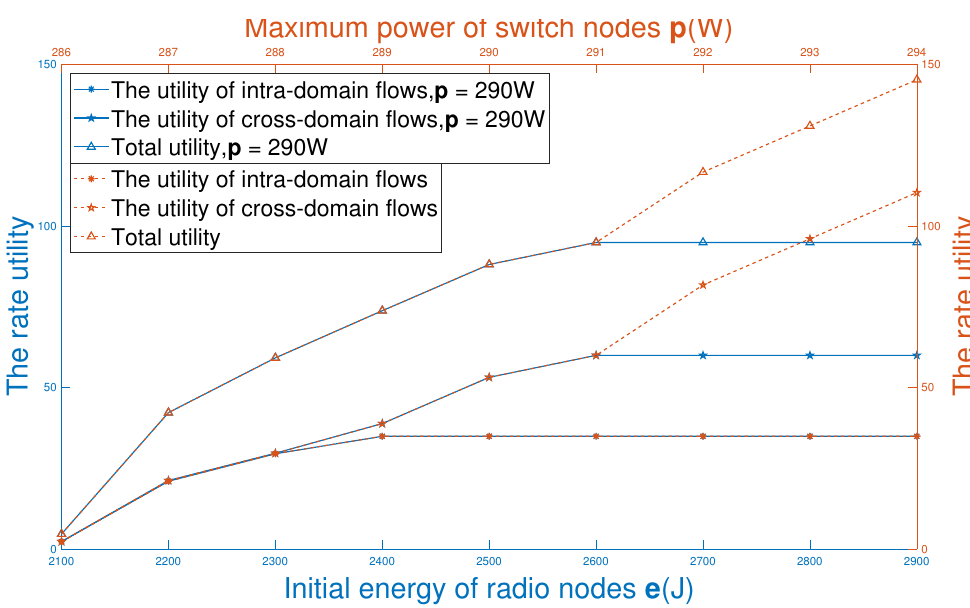
Figure 6. The impact of the energy limitation of network devices on the rate